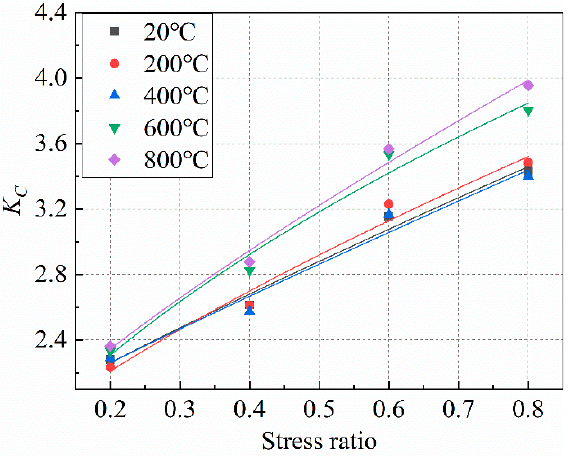
Figure 14. Fitting curve of lateral pressure enhancement factor K C test data. Table 8. Fitting parameters of K C formula for lateral pressure enhancement